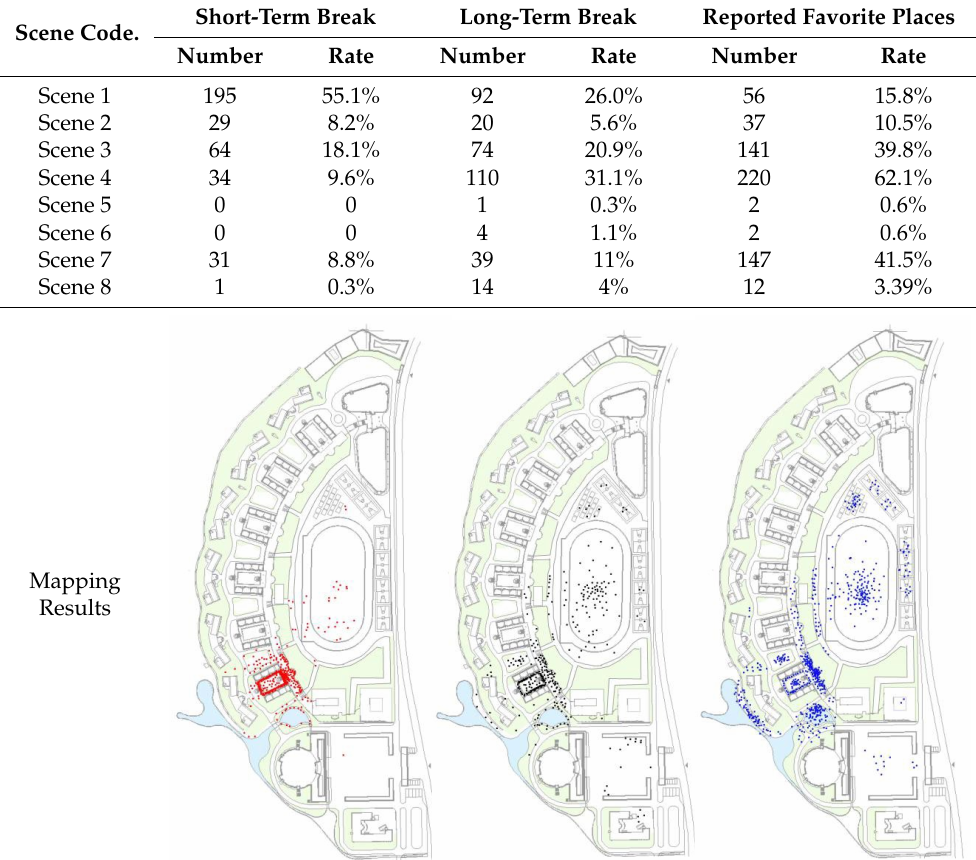
Table 5. Self-reported behavior during breaks and favorite places. Scene